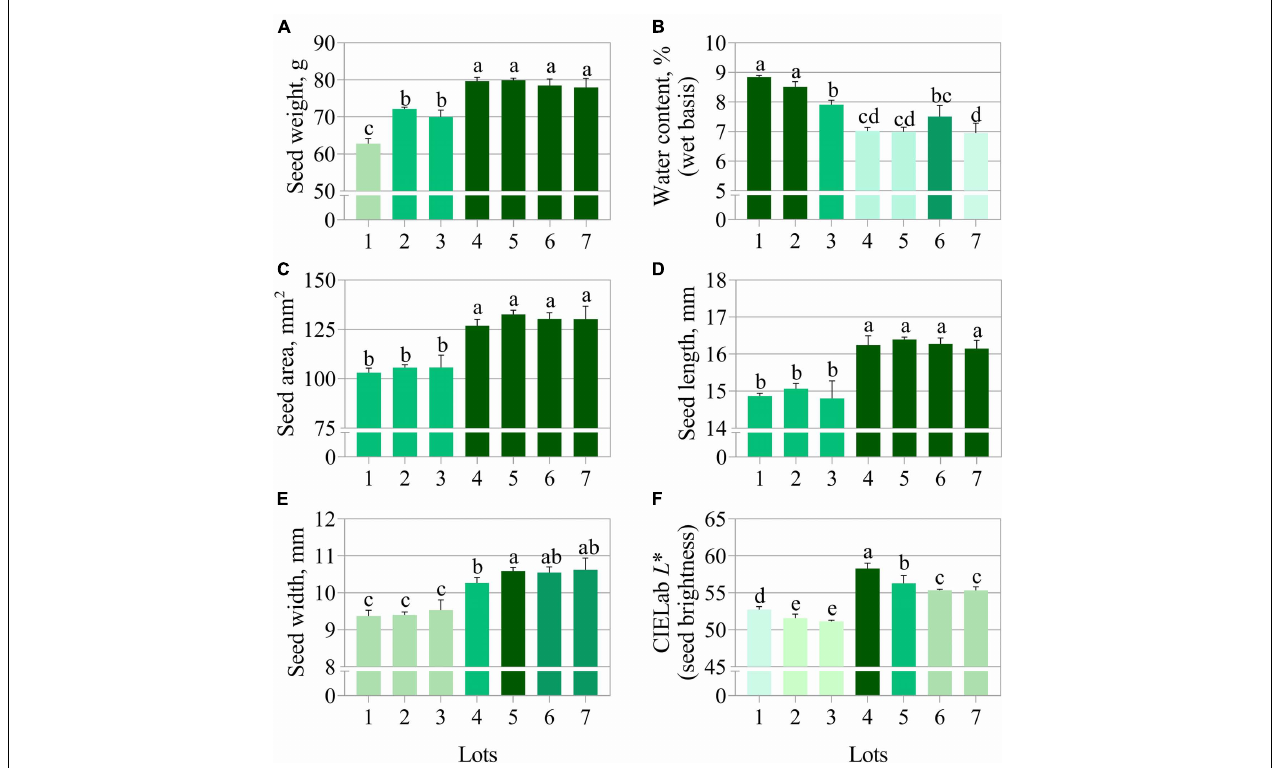
FIGURE 2 | Physical properties of seven seedlots of peanut ( Arachis hypogaea L.; cv. IAC OL3) based on fresh weight (A) , water content (B) , area (C) , length (D) , width (E) , and CIELab L ∗ (F) . The CIELab L ∗ represents the perceived brightness ranging from 0.0 (black) to 100.0 (white). Means ( ± standard deviation) with different letters indicate a significant difference ( p ≤ 0.05).